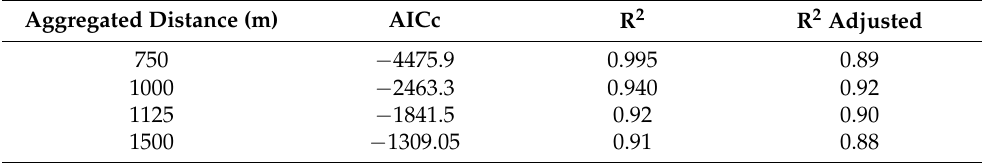
Table 5. Geographic Weighted Regression Results for the Respective Fire Products